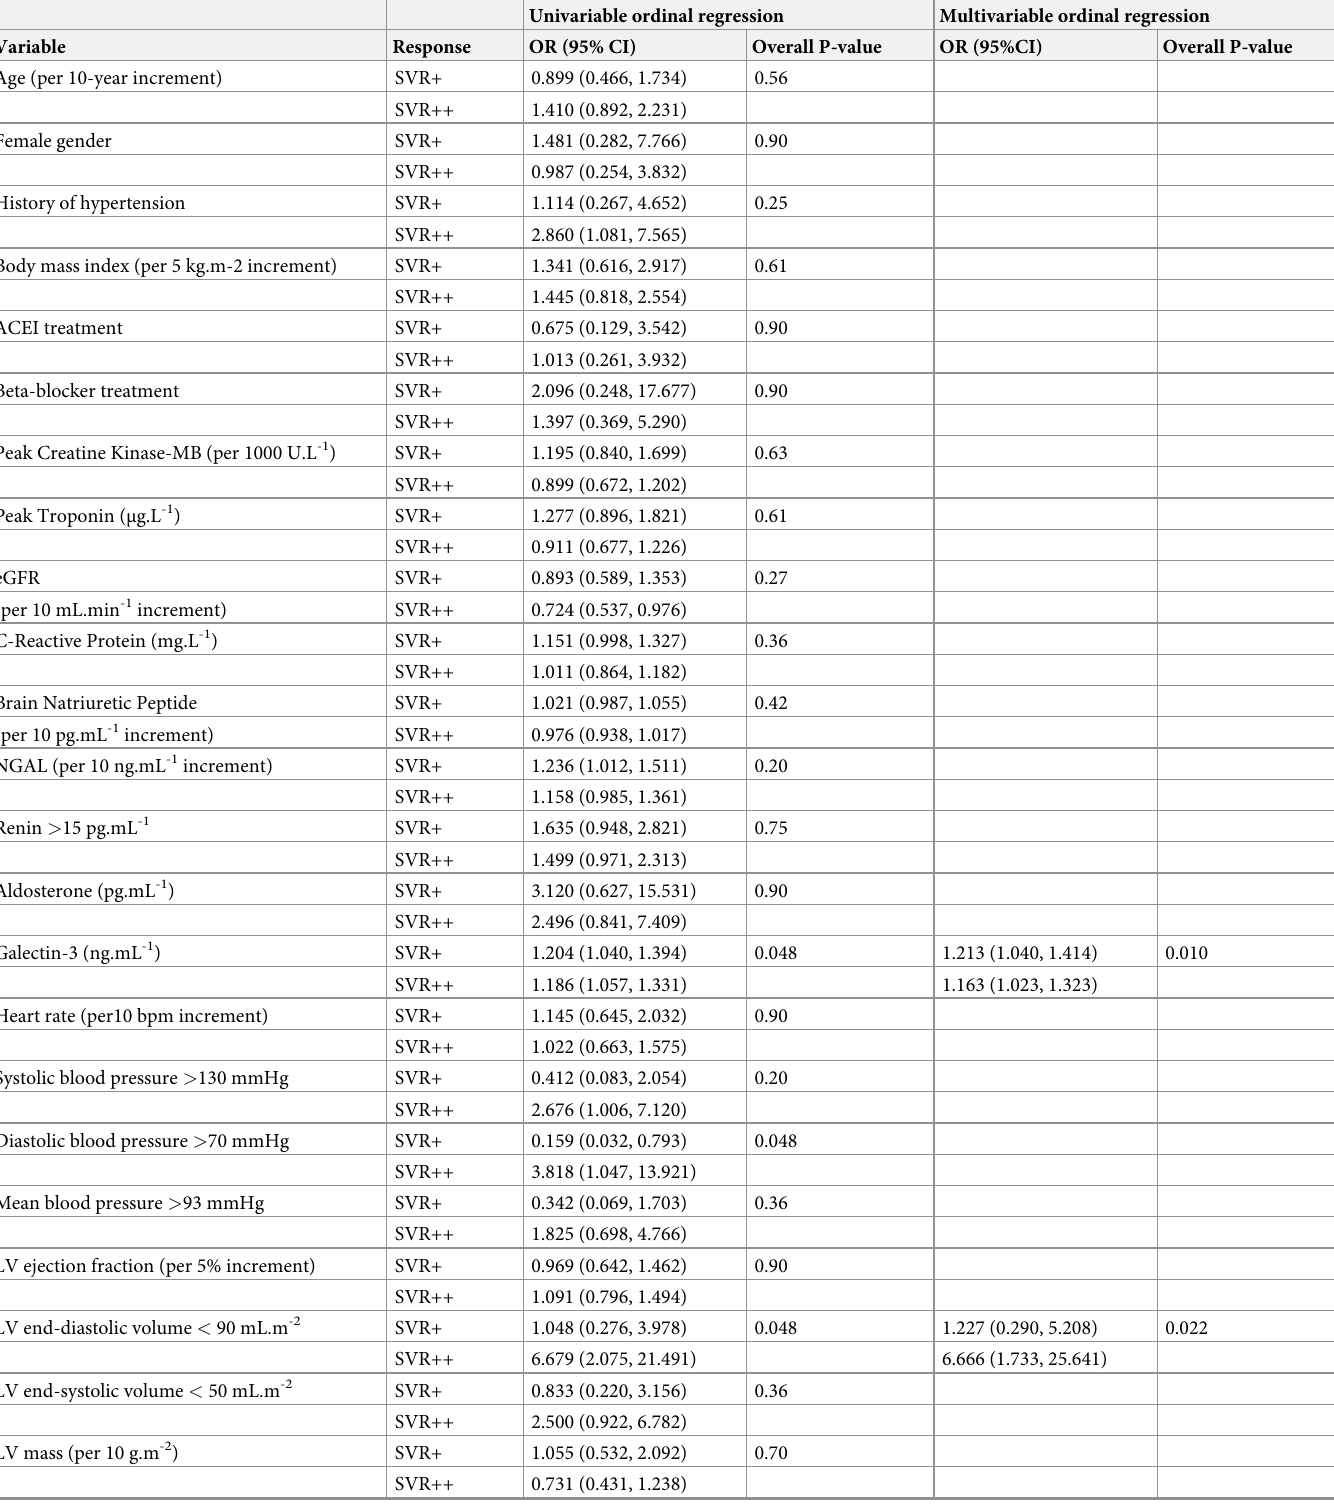
Table 3. Univariable and multivariable baseline predictors of SVR+ and SVR++ patients with odds ratios (OR) and 95% confidence